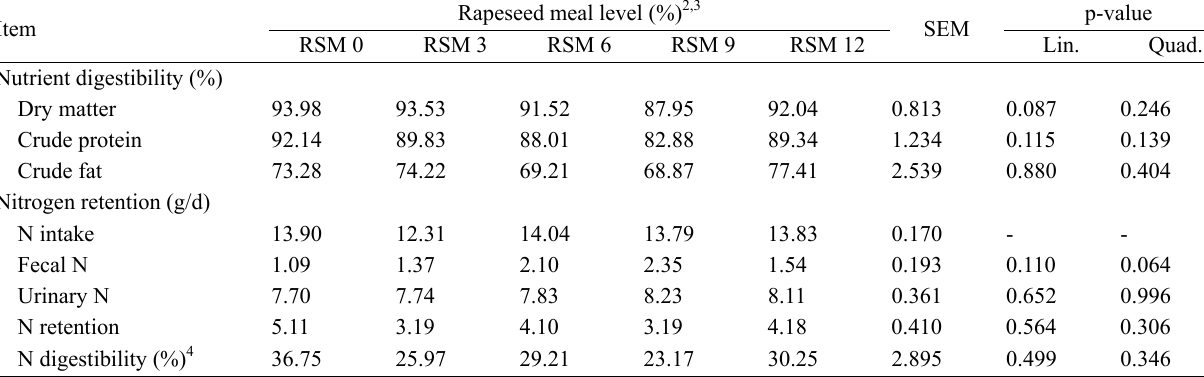
Table 9. Influence of dietary rapeseed meal (RSM) on nutrient digestibility in growing pigs 1